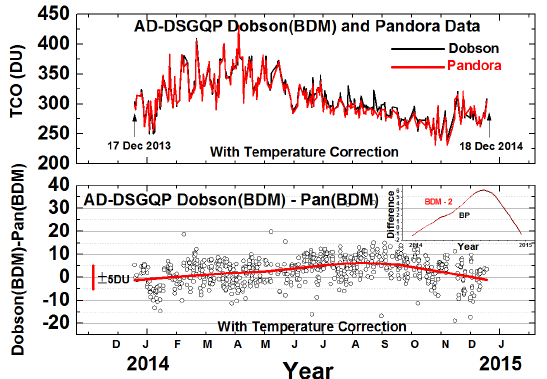
Figure A1. Temperature-corrected retrieved TCO data obtained from the Dobson #061 instrument using the BDM ozone cross sec- tions and Pandora #34 spectrometer using BDM. (b) The difference TCO(Dobson) – TCO(Pandora) with temperature corrections. The standard deviation from the red Lowess curve is ± 5DU. Inset com- pares the Lowess(0.5) difference curves for Dobson with Bass and Paur cross sections for Fig. 3 (Black) with the Lowess(0.5) differ- ence curves for BDM-2DU